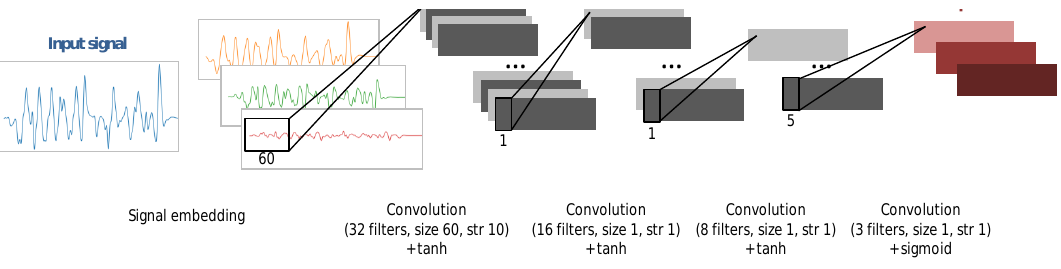
Figure 6. Architecture of the first part of the CNN, the SPN. Note that the last layer, which gives the output, is not present in the general N URSE N ET algorithm (Figure